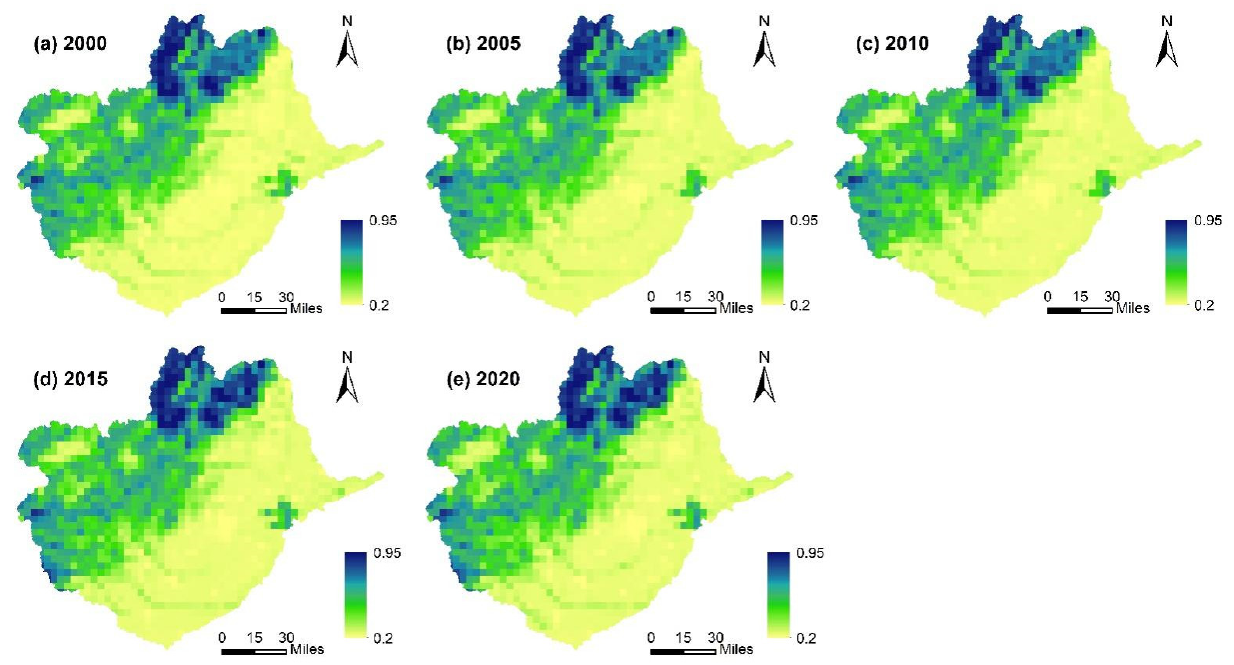
Figure 4. Spatial and temporal distribution of EQI in the Baiyangdian basin from 2000 to 2020.